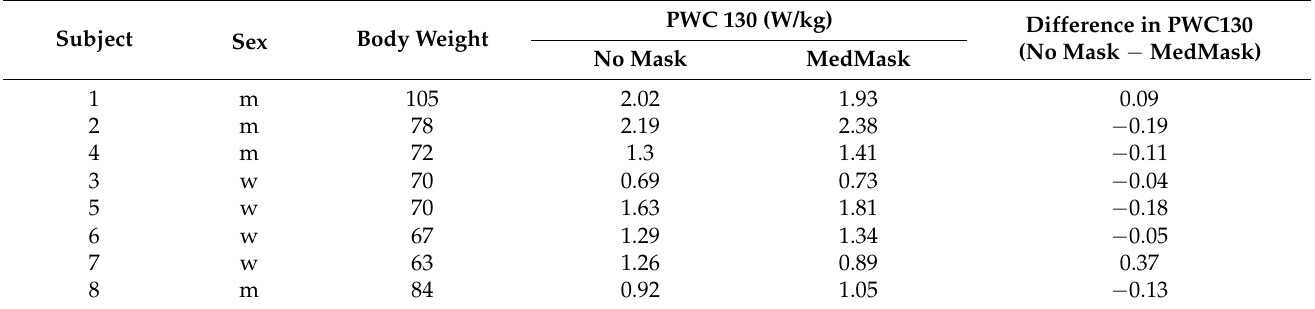
Table A1. PWC130 values of eight preliminary assessed participants.